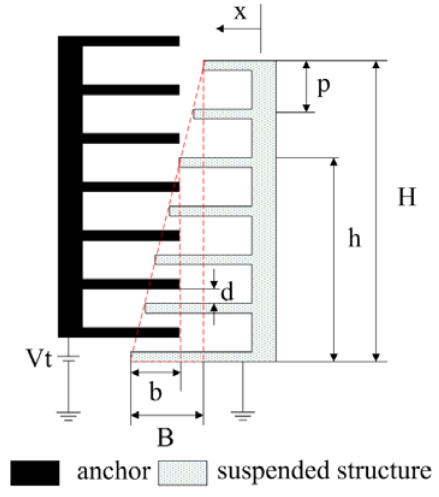
Figure 3. Tuning-comb of the tunable